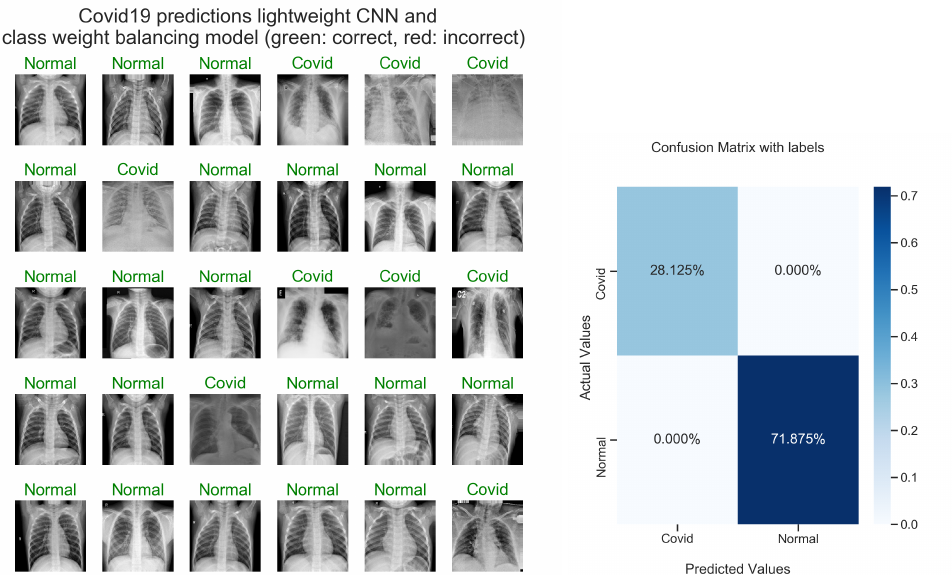
Figure 11. The best case of the proposed model with the Confusion Matrix.